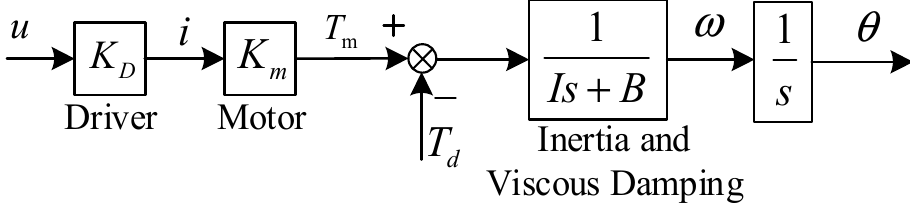
ω is the angular velocity of the shaft. Figure 2. Simplified linear model of DDCs, where